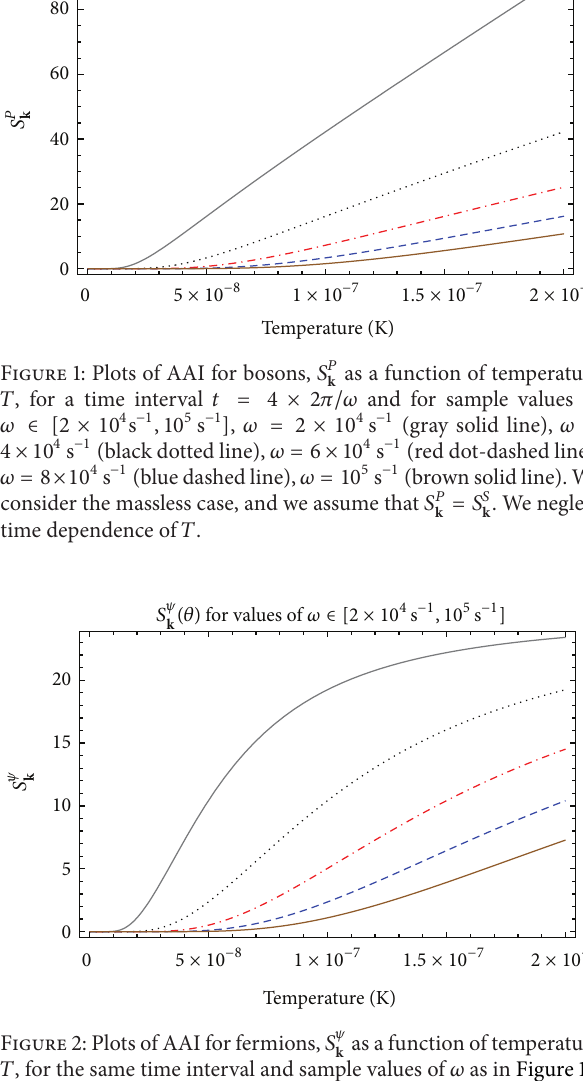
Figure 2: Plots of AAI for fermions, 𝑆 𝑇 , for the same time interval and sample values of 𝜔 as in Figure 1.